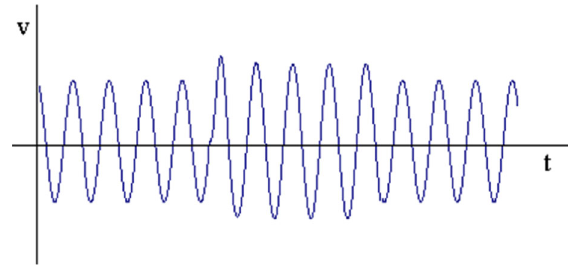
Fig. 2 Voltage waveform during Swell